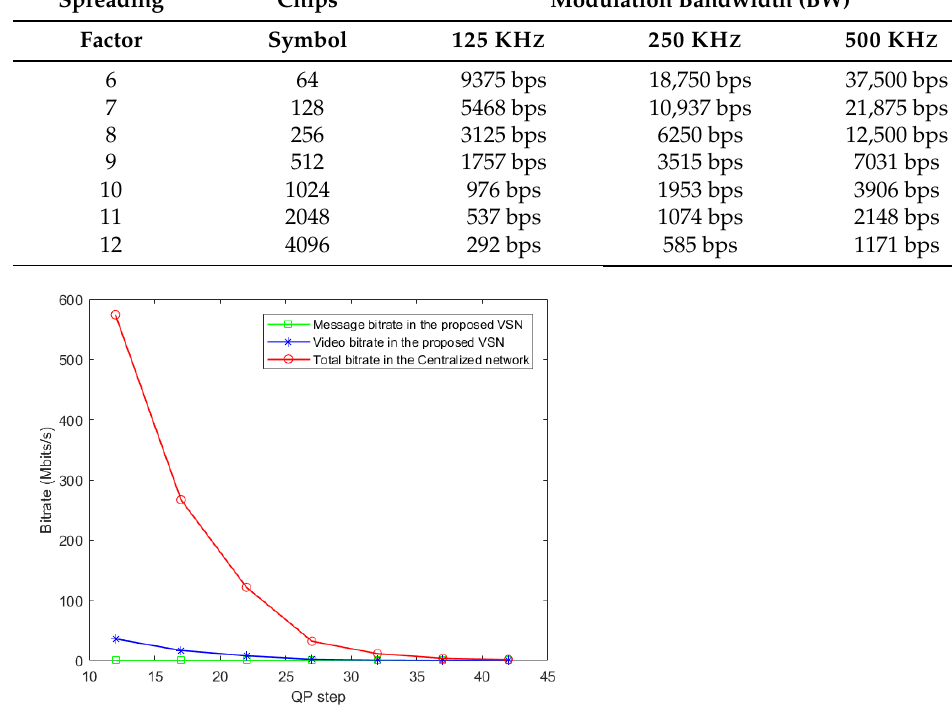
Figure 15. Average bitrate cost against QP step.